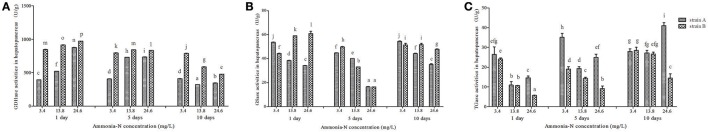
The activities (Mean ± SE) of GDHase, GSase and TGase in the hepatopancreas of strains A and B of L. vannamei in 1, 5 and 10 days exposure to different concentrations of ammonia-N. Each bar represents mean value from three determinations with standard error. Data in the same exposure time with different letters are significantly different (p < 0.05) between treatments. (A) GDHase activity in the hepatopancreas of strain A and B. (B) GSase activity in the hepatopancreas of strain A and B. (C) TGase activity in the hepatopancreas of strain A and B. Keys: GDHase, Glutamate dehydrogenase; TGase, Transglutaminase; GSase, Glutamine synthetase.